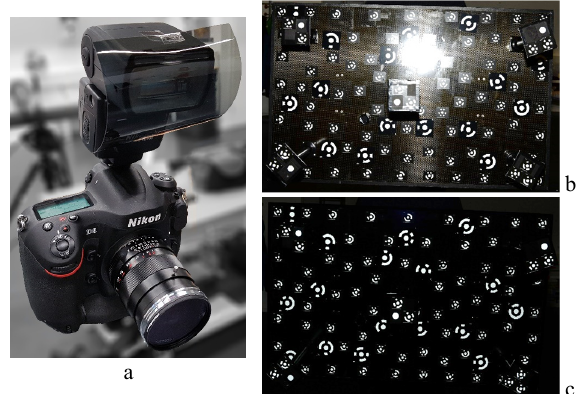
Figure 6. Nikon D4 with 35mm-ZEISS-lens with polarising filter and eccentric flash with polarising film (a); carbon test field captured without (b) and with (c) crossed polarising filters.